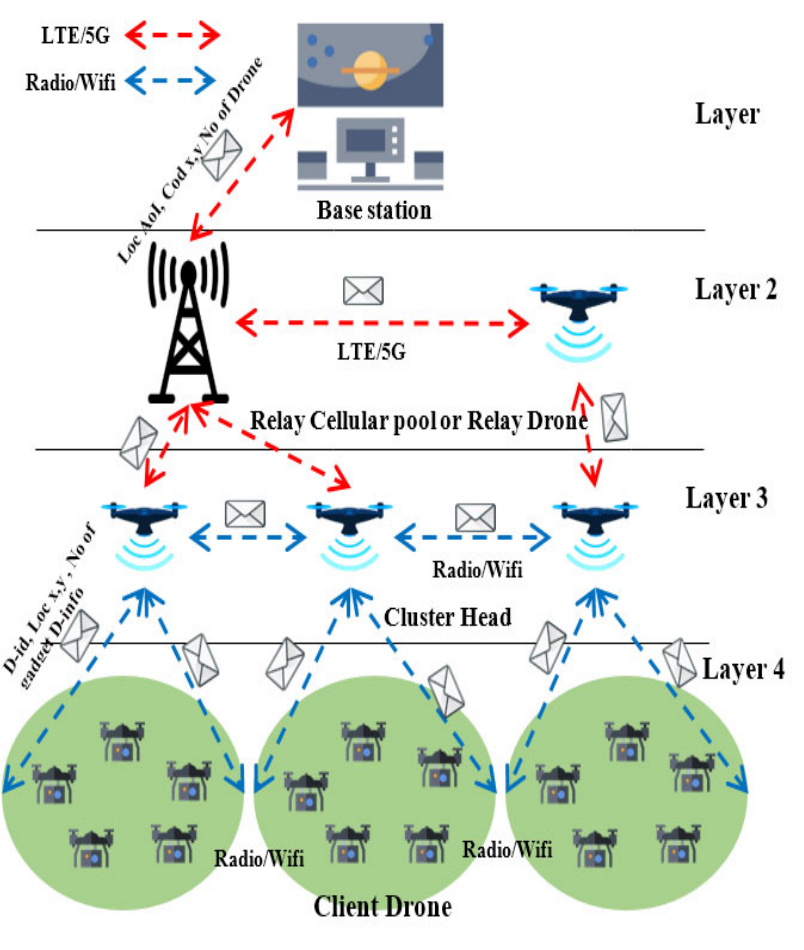
Figure 1. Architecture diagram for proposed work.